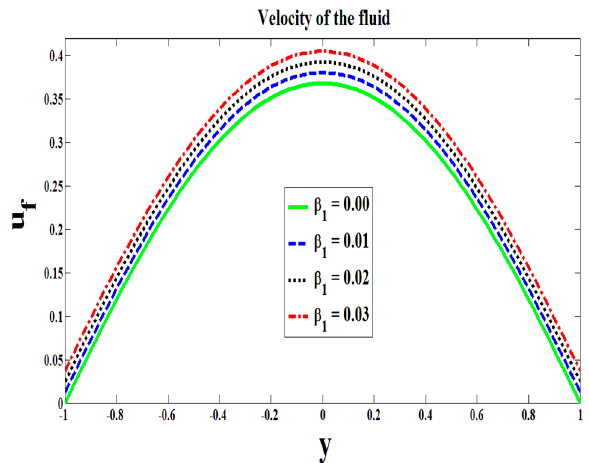
Figure 8. Effects of slip parameter on the flow.